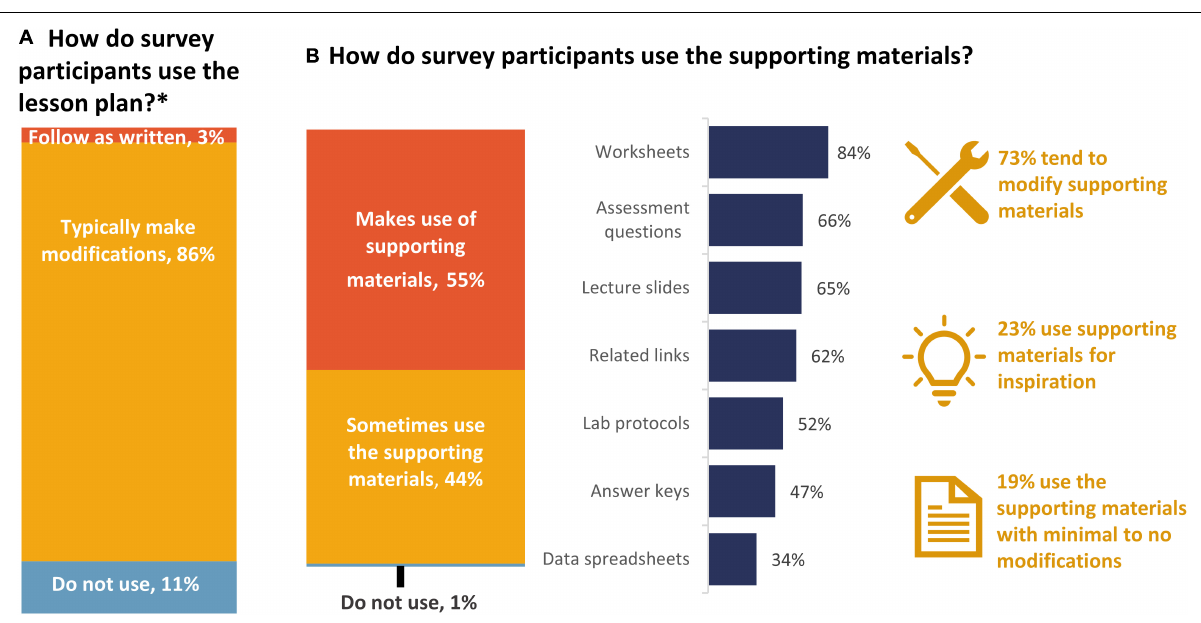
FIGURE 6 | Survey participants’ Adaption of resources, particularly that of (A) the lesson plan and timeline and (B) the supporting materials. ∗ Indicates that one or two survey participants did not answer this